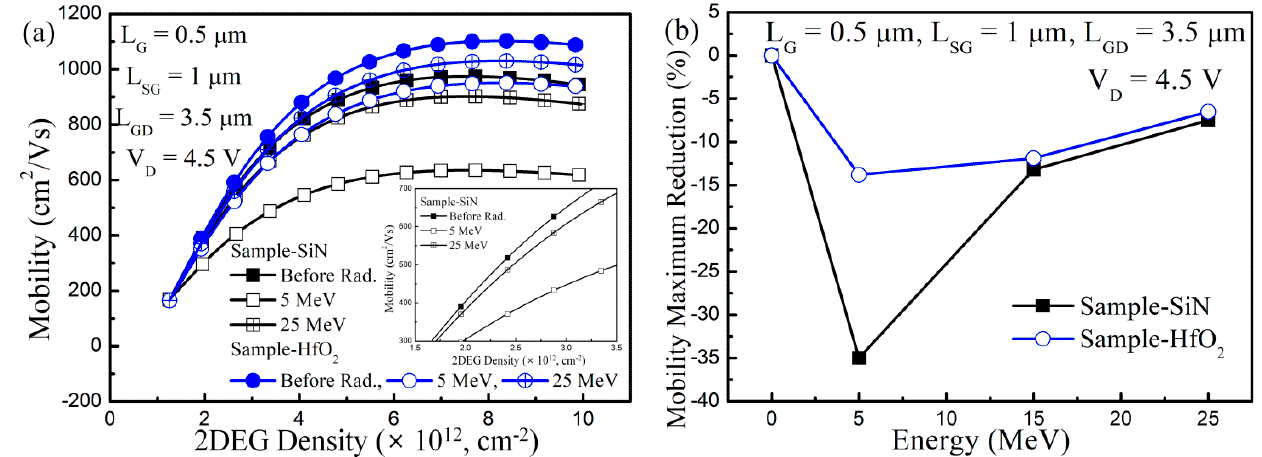
Figure 6. Carrier mobility extraction before and after proton irradiation in the GaN-based MIS- HEMTs for the 5 nm-thick Si 3 N 4 and the HfO 2 gate insulator. ( a ) Carrier mobility vs 2DEG density before and after proton irradiation at 5 MeV and 25 MeV; ( b ) Carrier mobility maximum reduction vs. the irradiated proton energy. Inset in ( a ) shows the zoomed-in carrier mobility behavior at a low 2DEG density regime in GaN-based MIS-HEMTs for the 5 nm-thick Si 3 N 4 gate insulator before and after proton irradiation at 5 MeV and 25 MeV.